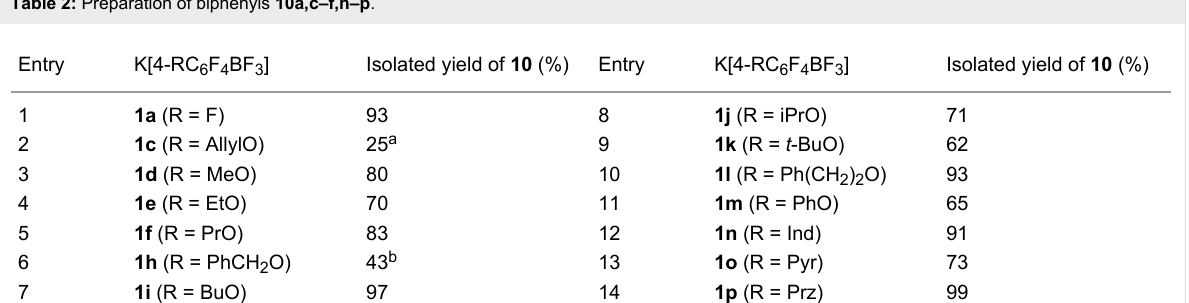
Table 2: Preparation of biphenyls 10a,c–f,h–p